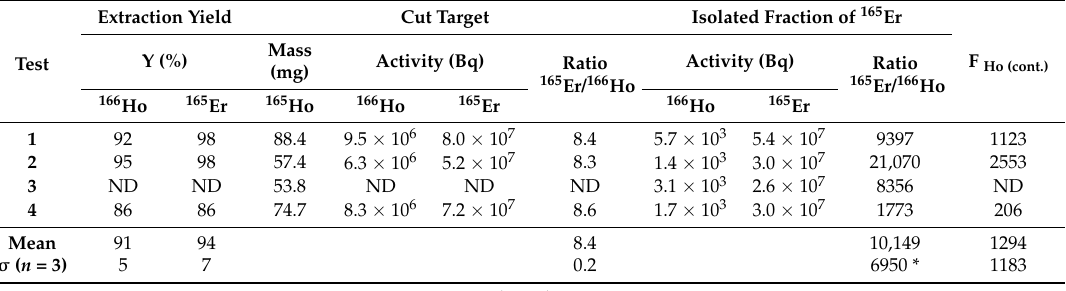
Table 4. Analysis of isolated fraction from 4 tests on semi-automated separation system.